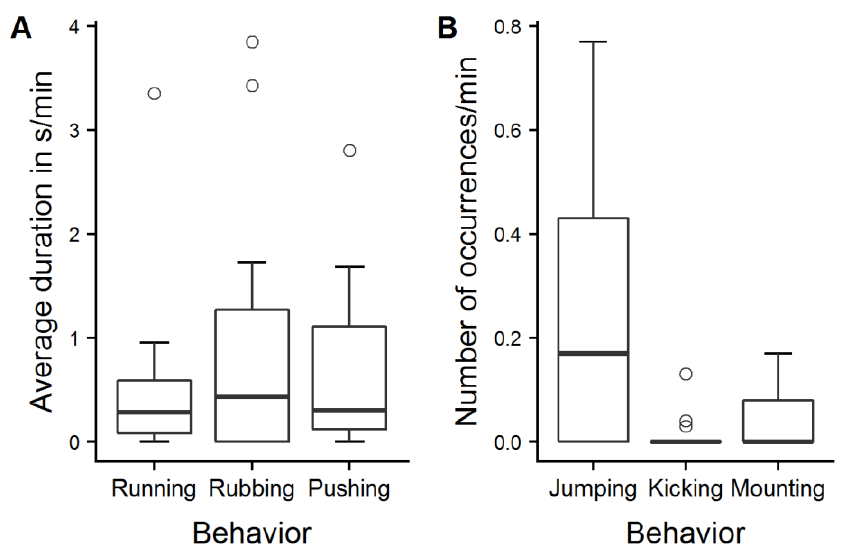
Figure 5. Play behavior. Average duration in s/min ( A ) and number of occurrences/min ( B ) of different patterns of play behavior displayed by 13 calves in the play test selected for evaluation of the effect of play behavior on sIgA.